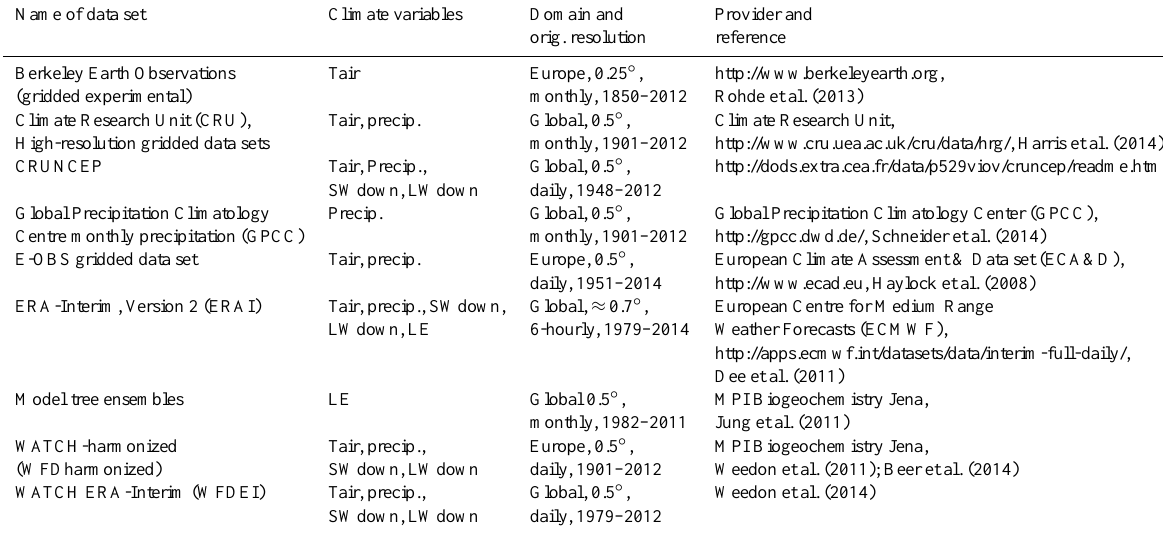
Table 1. Data sets used for bias correction and